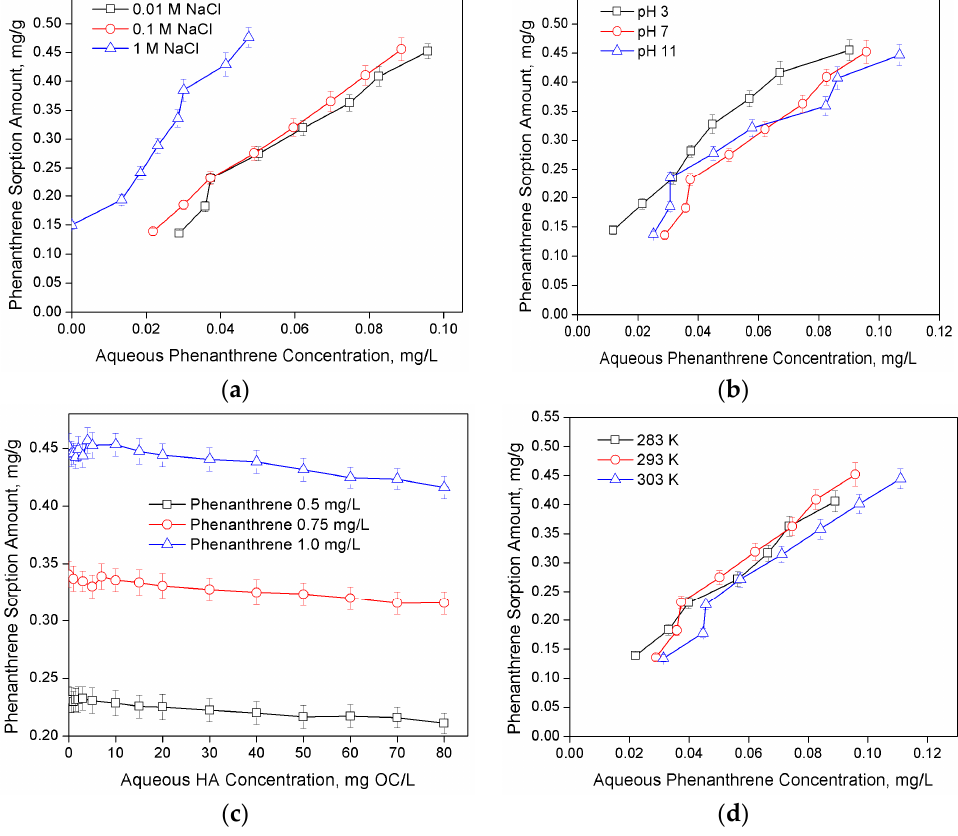
Figure 1. The phenanthrene sorption data at different ( a ) ionic strength; ( b ) pH; ( c ) humic acid (HA); and ( d ) temperature levels.